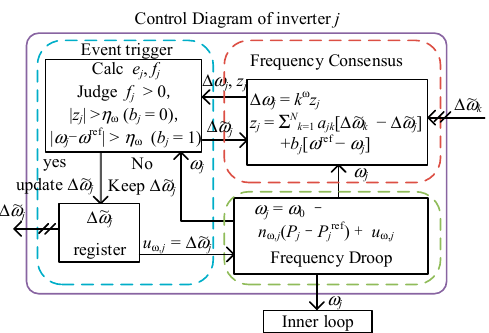
Figure 8. Block diagram of the consensus algorithm with event-triggered mechanism for secondary- frequency regulation control.